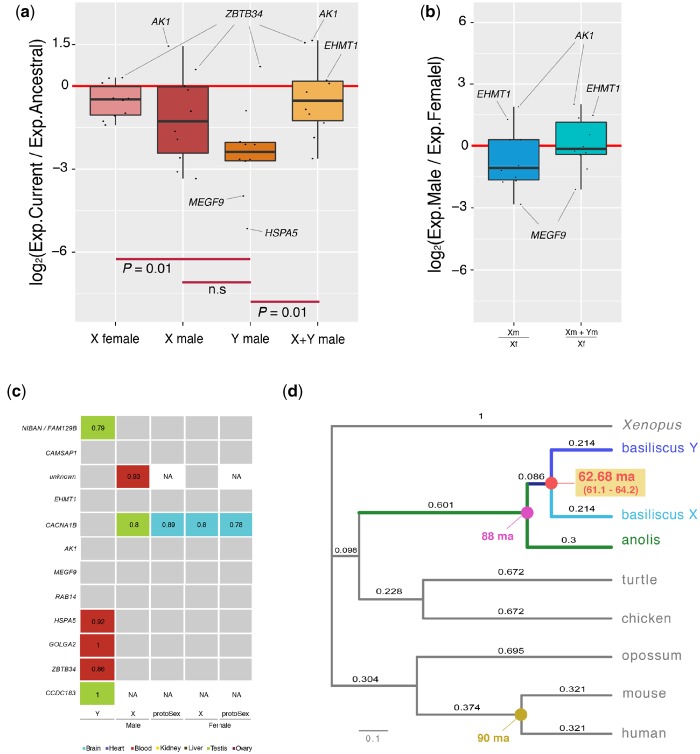
—Analyses of XY gametologues. (a) Boxplots representing the current/ancestral expression ratio of X gametologues in females, X gametologues in males, Y gametologues in males, and the added expression of X and Y gametologues in males (n = 10 genes). Significant differences (Mann–Whitney U test). Genes with the highest and lowest expression ratios are indicated. (b) Boxplots representing the expression balance of XY gametologues between the two sexes, that is, the X gametologues expression levels in males compared with those in females, as well as the added expression levels of X and Y gametologues in males compared with the expression levels of the X gametologues in females (n = 10 genes). Genes with the highest and lowest expression ratios are indicated. (c) Tissue-specificity index (TSI) of XY gametologues and proto-sex genes (tissue-specificity of orthologous genes in the chicken and the green anole) in males and females. Genes with a tissue-specificity index below 0.7 are colored in gray. Genes with a tissue-specificity index above 0.7 are filled using the colors shown at the bottom of the figure; TSI values are indicated. (d) dS tree built using the concatenated coding nucleotide sequences of stratum 1 genes and orthologous sequences in other tetrapod species. The age of the sex chromosome system in corytophanids was obtained by comparing specific branch lengths and the age at specific nodes (see Materials and Methods). Age estimates for specific nodes are based on Zheng and Wiens (2016). Millions of years ago are denoted by “Ma.”